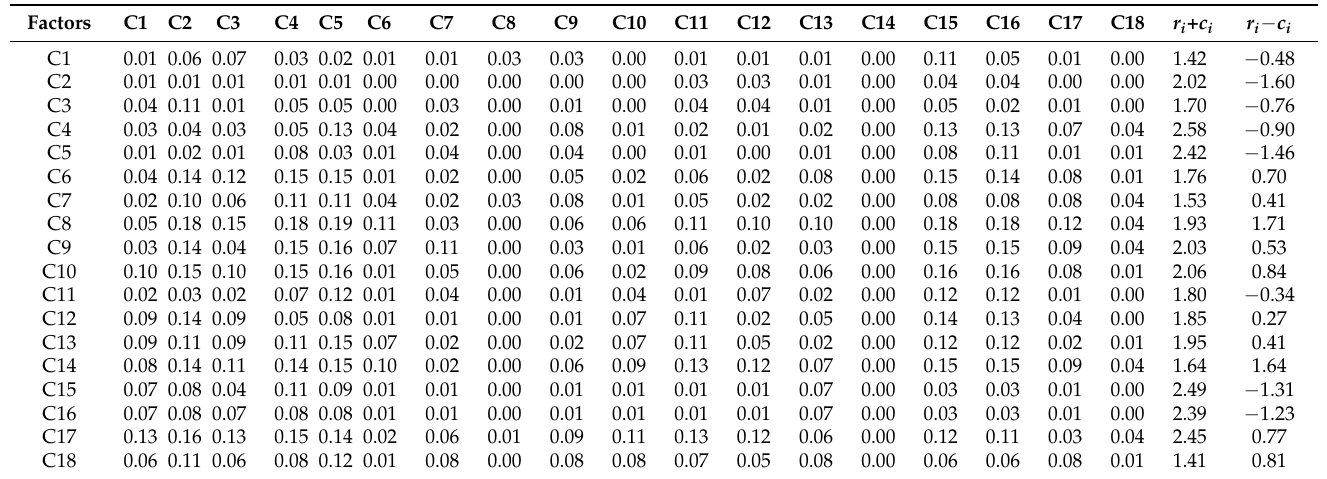
Table 3. Comprehensive influence